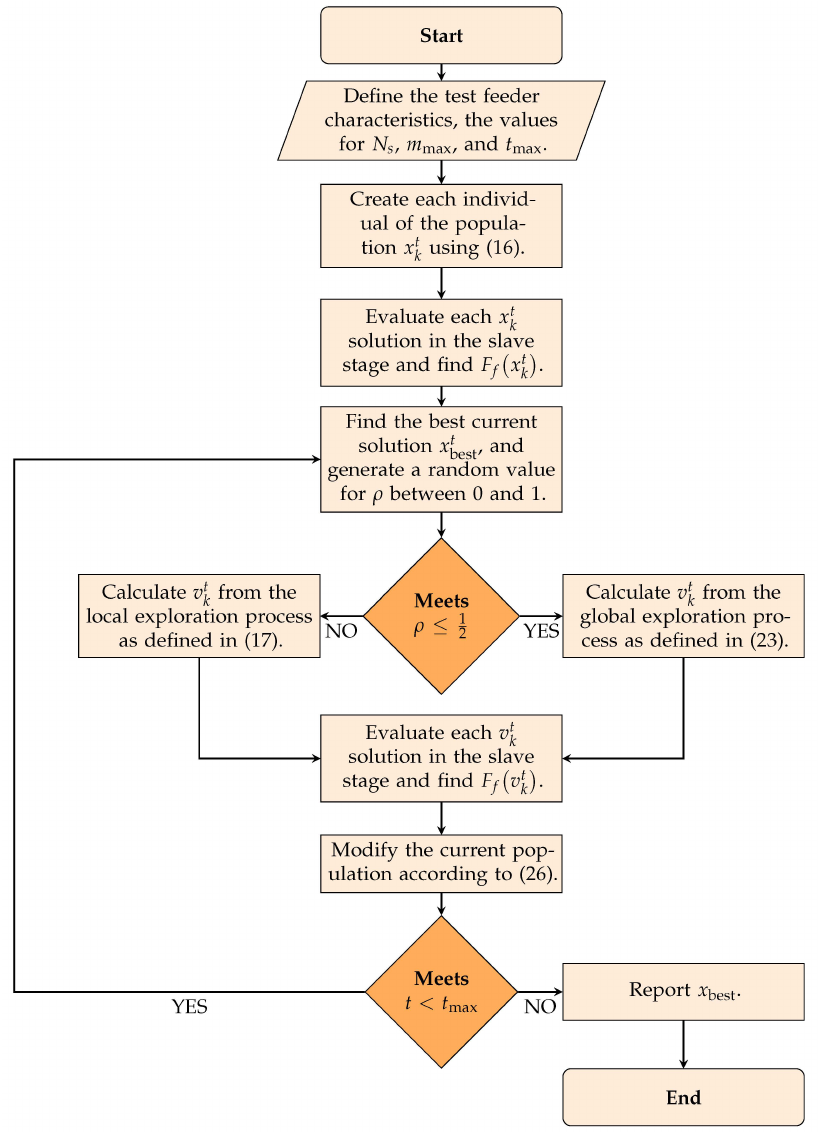
Figure 1. Flowchart for the improved